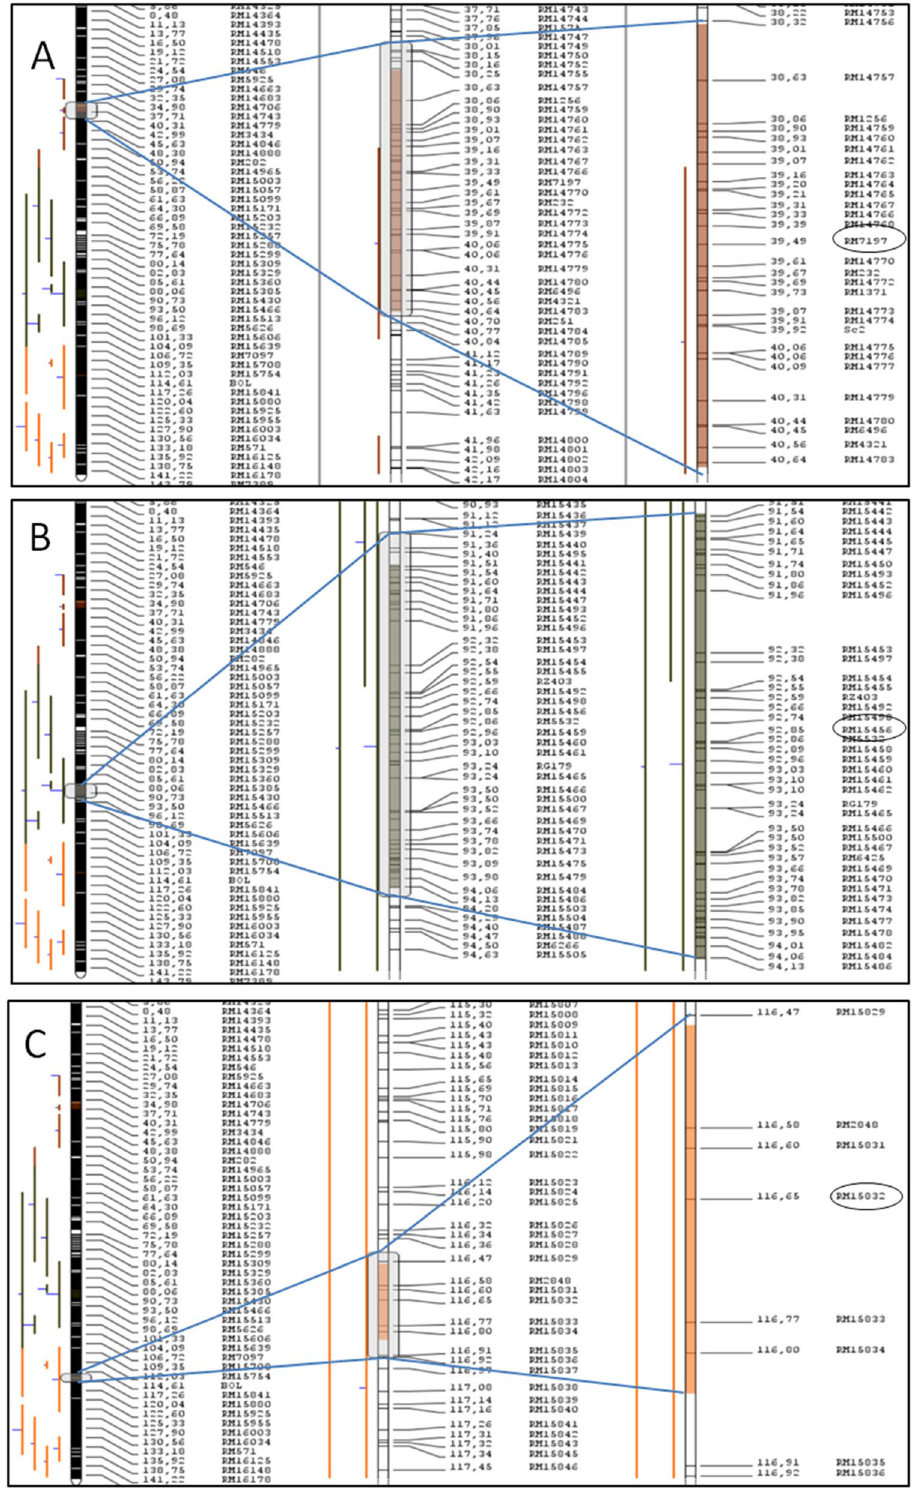
Figure 4. Magnified view of significant meta-QTL identified in the study ( A ) MQTL3.1 having interval of 0.49 Mb with peak marker RM7197, ( B ) MQTL3.2 having interval of 0.63 Mb with peak marker RM15456 and ( C ) MQTL3.3 having interval of 0.08 Mb with peak linked marker